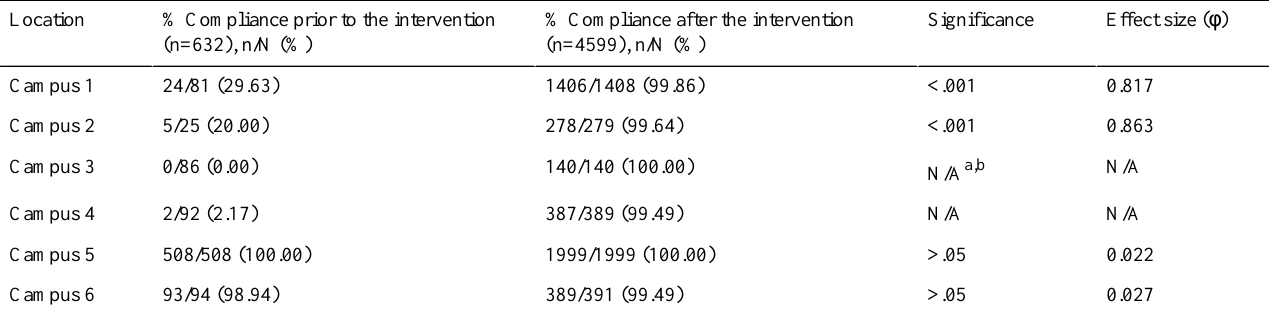
Table 2. Fisher exact test results and compliance rates prior to and following the iPad intervention at each location.